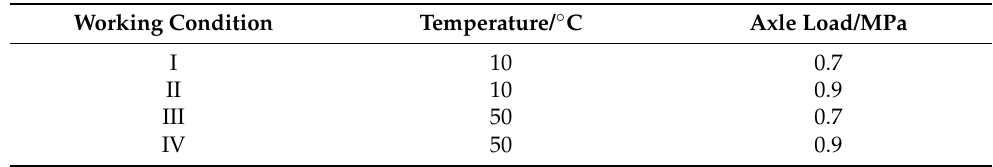
Table 5. Working condition specifications.